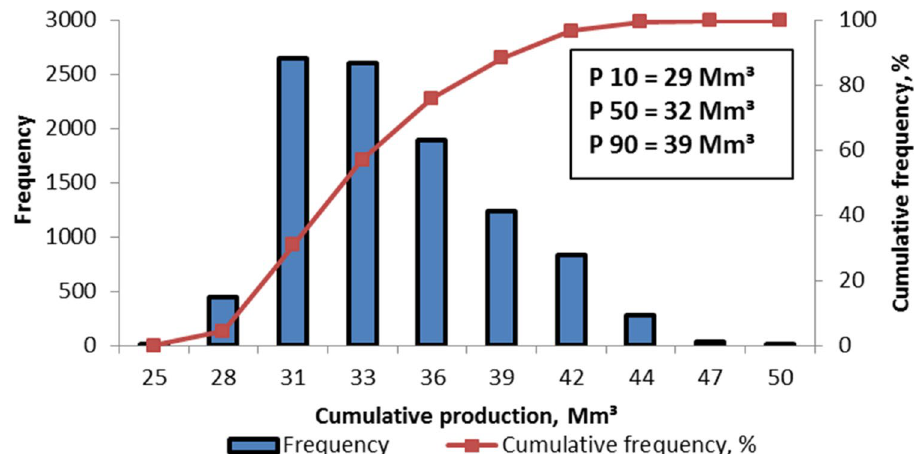
Fig. 17 Results of Monte Carlo simulations showing the cumu- lative oil